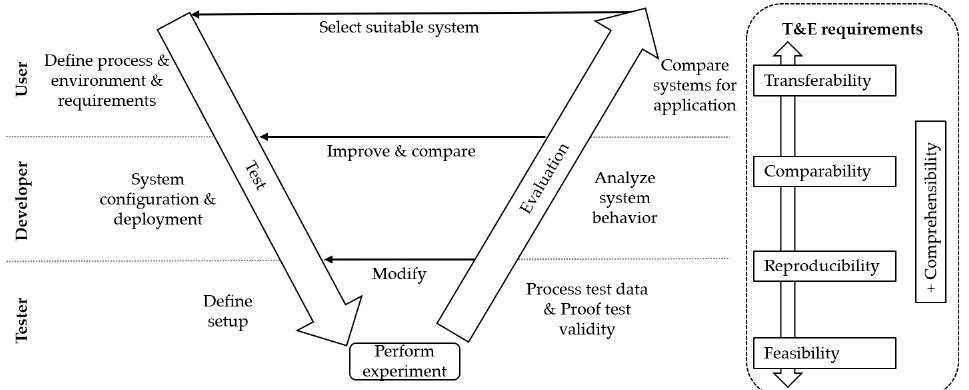
Figure 2. The V-Model—illustration of the application-driven T&E process with the involved stake- holders, their functions, and